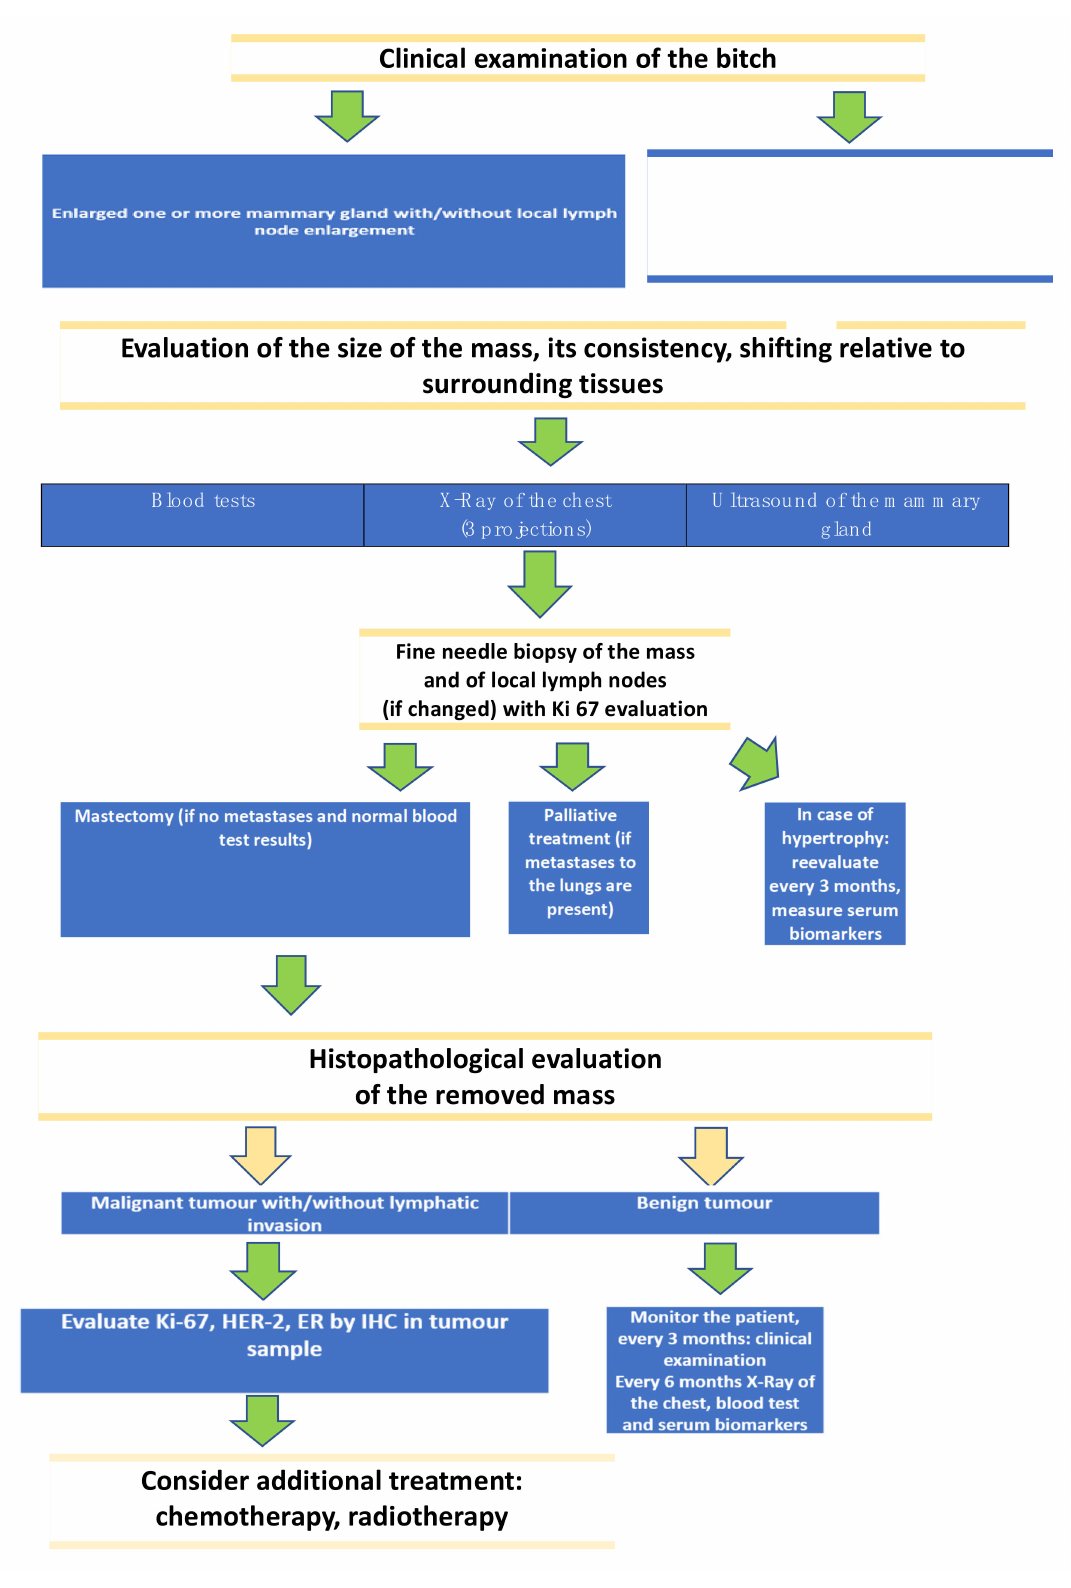
Figure 1. Proposal of the procedure of canine mammary tumors